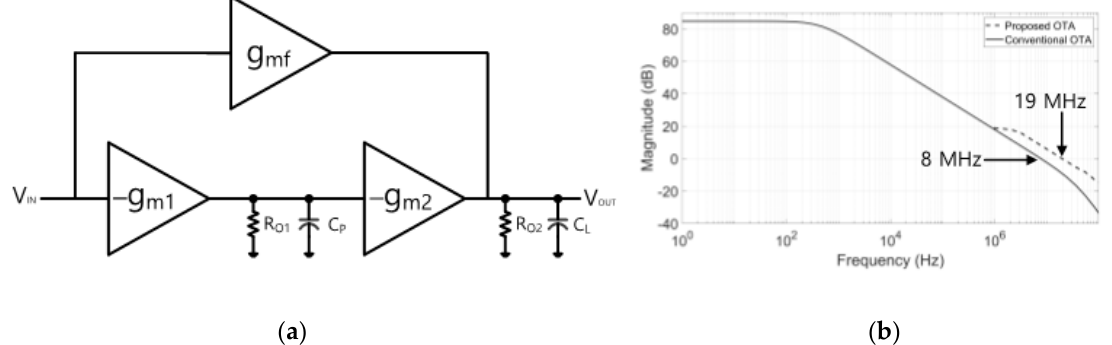
Figure 6. Proposed OTA topology. ( a ) Block diagram; ( b ) comparison of bode plots.